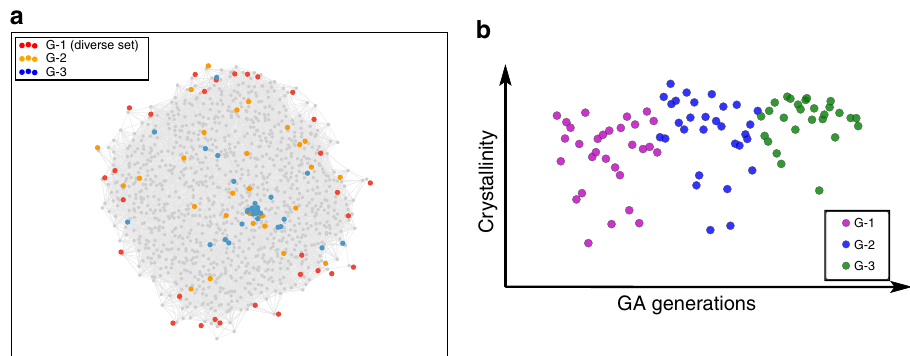
Fig. 1 Optimisation of synthesis condition of Cu-HKUST-1. a Multidimensional scaling projection of the 9-D space of parameters onto a 2-D plane. In this representation, similar conditions are plotted close to each other, and connected if they have normalized pairwise distance below 0.1. Grey dots visualize the extent of the entire bounded (chemical) space, represented by mapping the set of 1000 most diverse synthesis conditions obtained from the MaxMin method. The red dots are the fi rst 30 of this set which are used for the fi rst experiments (G-1), the orange and blue dots mark the second (G-2) and third (G-3) generations obtained from the fi rst via the genetic algorithm (GA). b Progress in crystallinity during GA optimization. The colour of dots indicates the generation in the GA. (HKUST = Hong Kong University of Science and Technology) Table 1 BET surfaces and the corresponding synthesis conditions of the fi ve samples with the highest